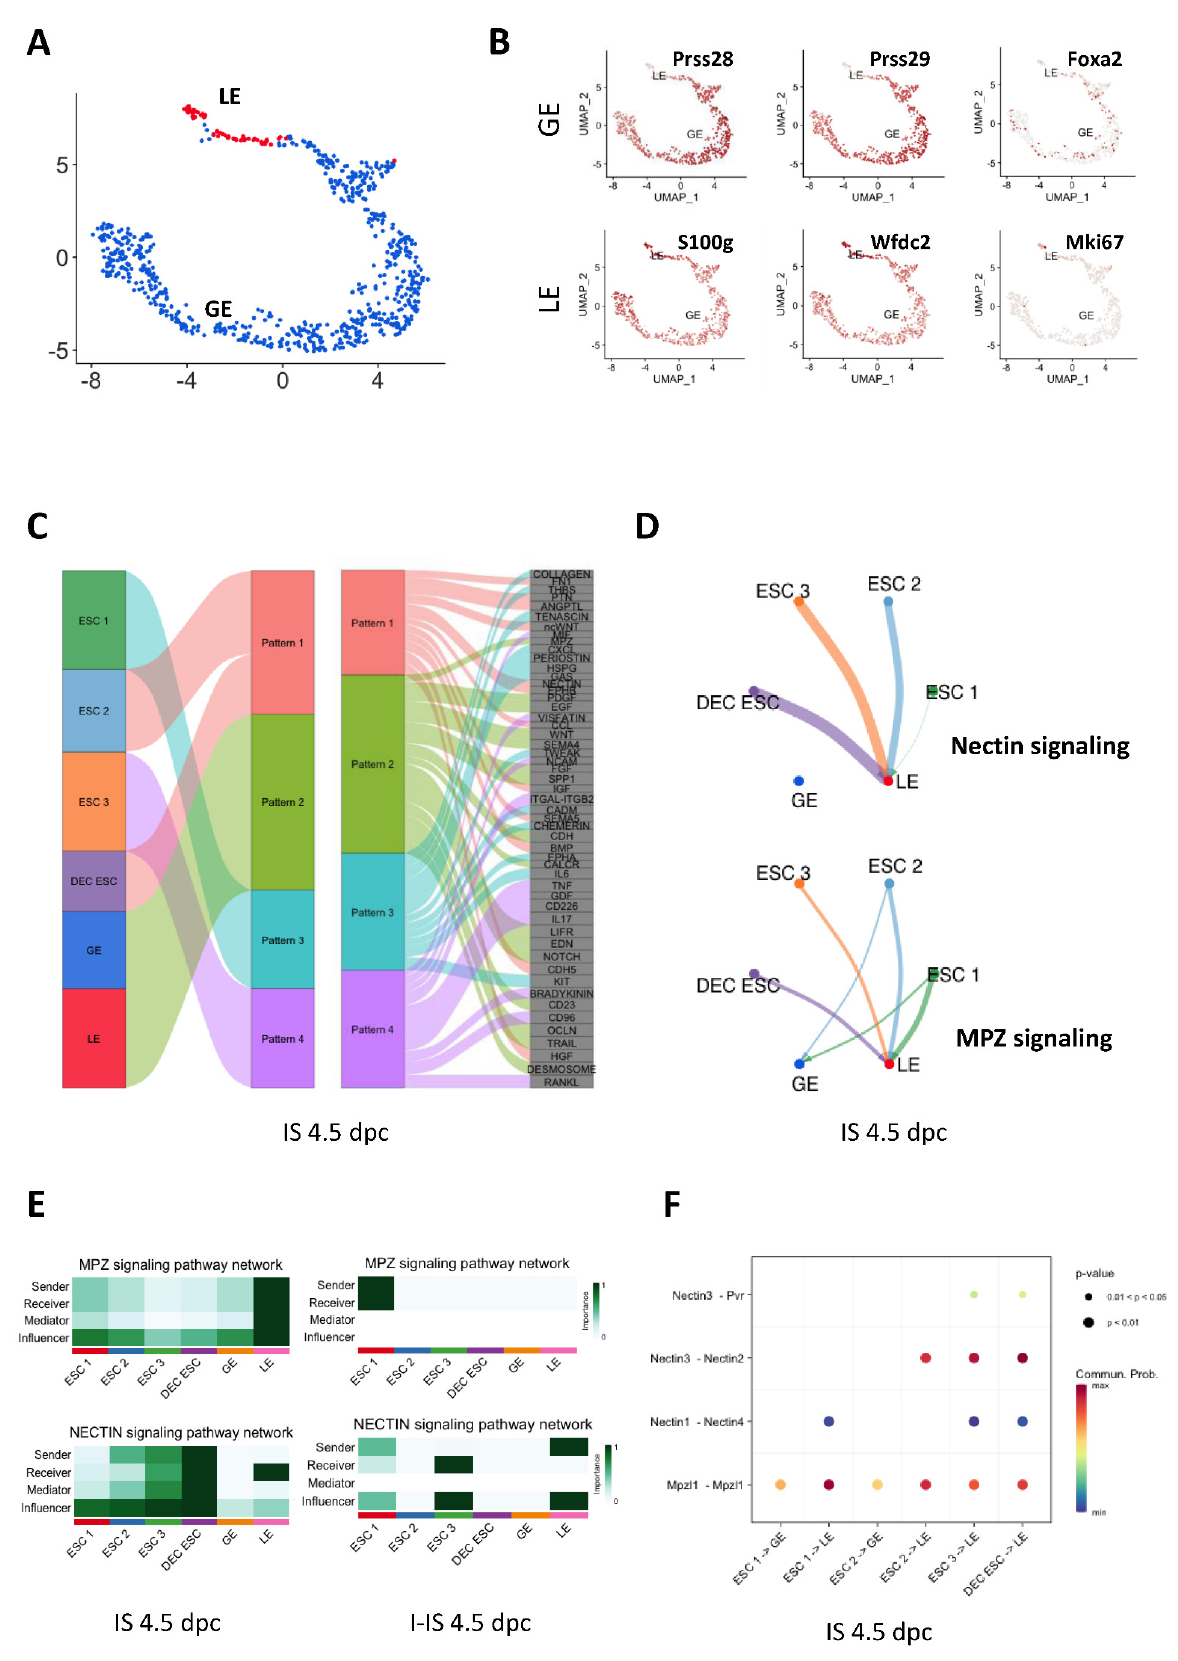
Figure 5. The endometrial epithelial cells (EECs) in mice uteruses and their interactions with